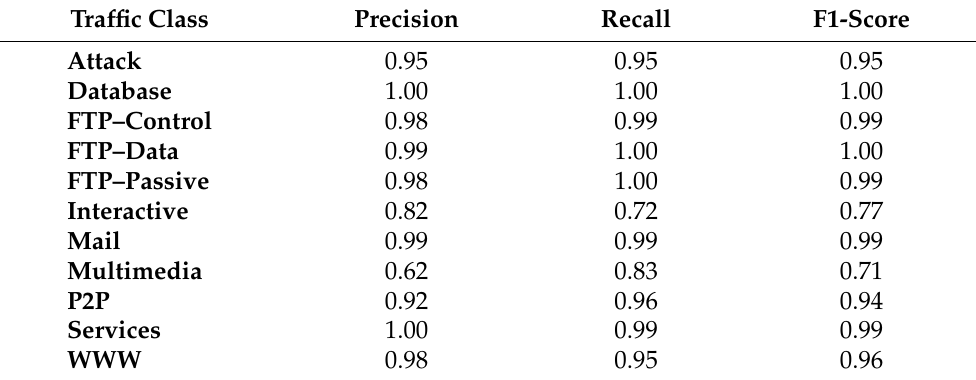
Table 3. Precision, recall, and F1-score per class for SVM classification.